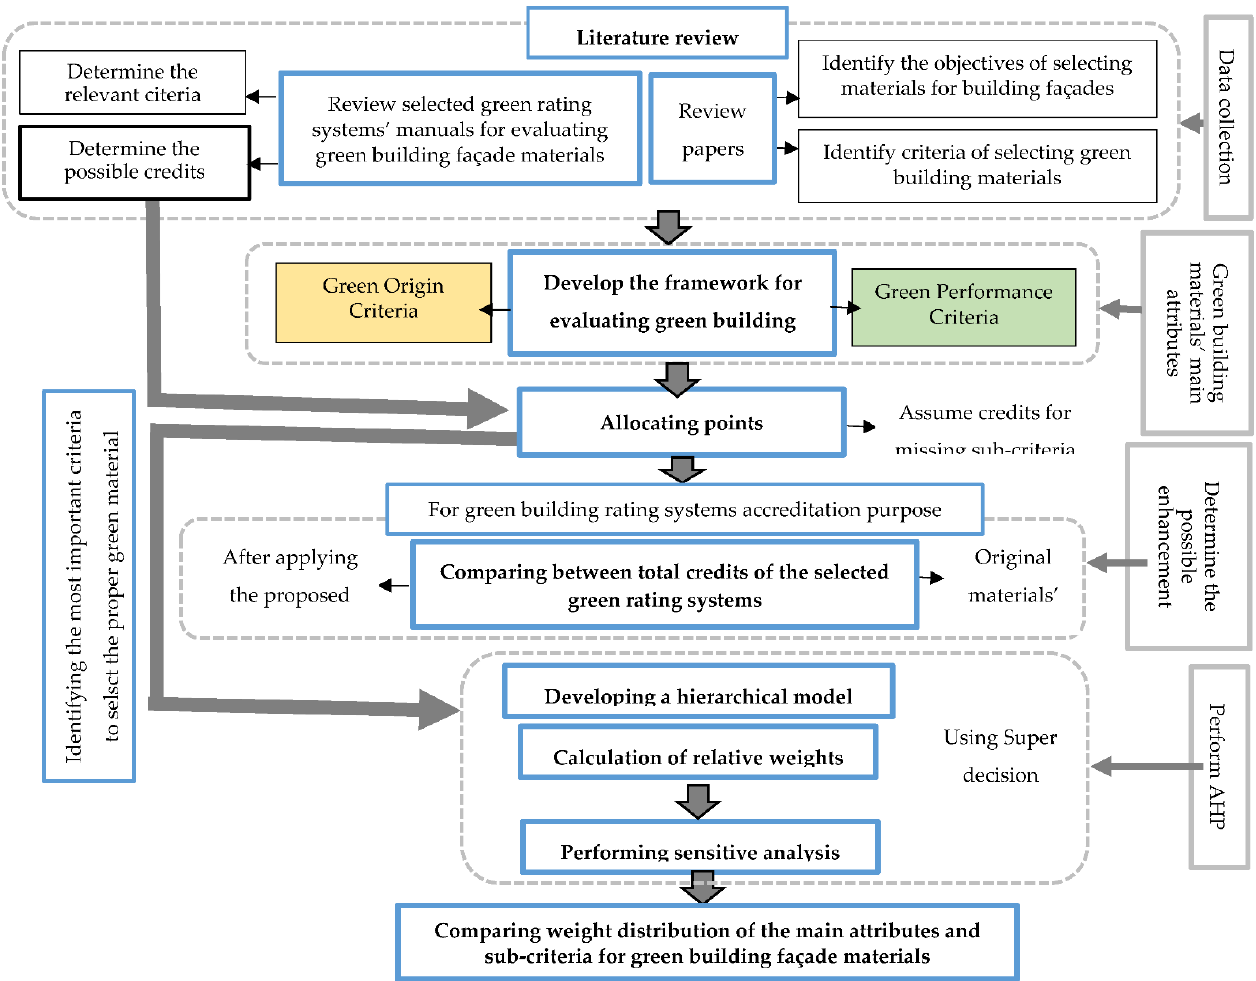
Figure 2. Research methodology.